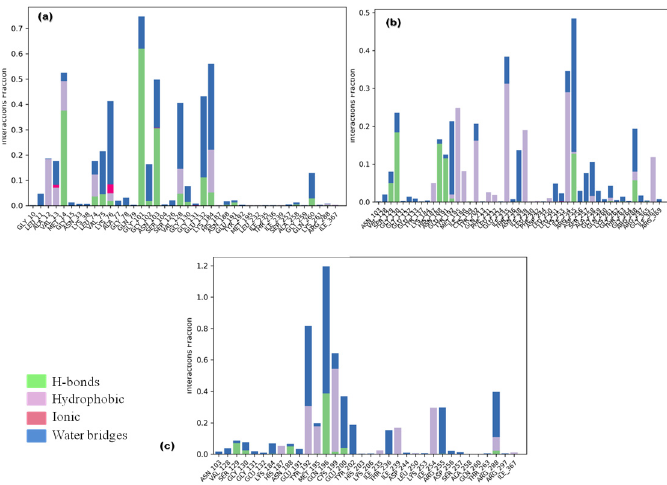
Figure 7. Protein–ligand interaction types between 6-PGD and candidate compounds (( a ) secoisolariciresinol, ( b ) syringaresinol and ( c ) cleomiscosin A) during the simulation. Green color: hydrogen bonds; purple color: hydrophobic; pink color: ionic; blue color: water bridges.